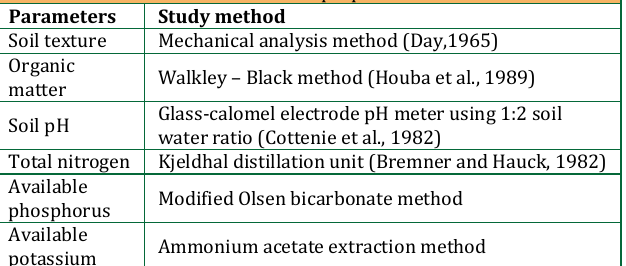
Table 2: Laboratory analytical techniques for different soil physical and chemical properties Parameters